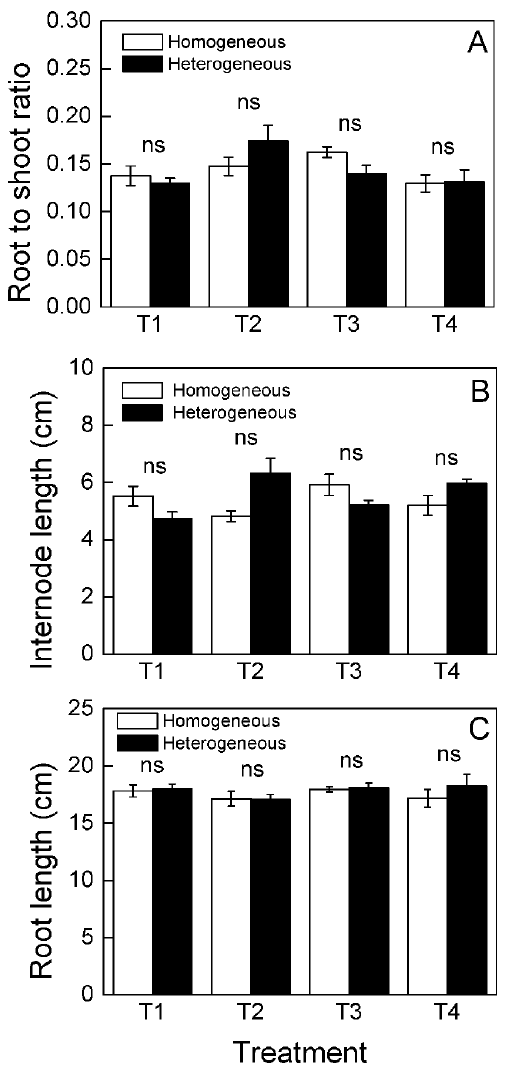
Figure 5. Different responses of root to shoot ratio and morphological characters of Buchloe dactyloides between homogeneous and heterogeneous patches at clonal fragment level. Mean values ( 6 S. E.) of root to shoot ratio (A), internode length (B) and root length (C) between the homogeneous and heterogeneous patches of the same treatment are given. * means P , 0.05. ns means P . 0.05. Treatment codes are in Figure 1.